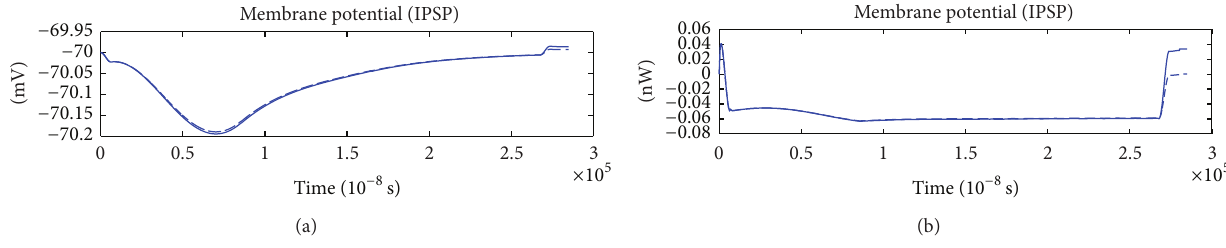
Figure 23: The IPSP and the corresponding energy function. 𝑟 0𝑚 = 0.0001 Ω , 𝑟 1𝑚 = 0.1 Ω , 𝑟 2𝑚 = 1000 Ω , 𝑟 3𝑚 = 0.1 Ω , 𝑟 𝑚 = 1000 Ω , = 1 𝜇 F, 𝐿 = 50 𝜇 H, 𝑖 = −0.7 𝜇 A, and 𝑄 = 2 × 10 −7 𝜇 A. 𝐶 𝑚 𝑚 0𝑚